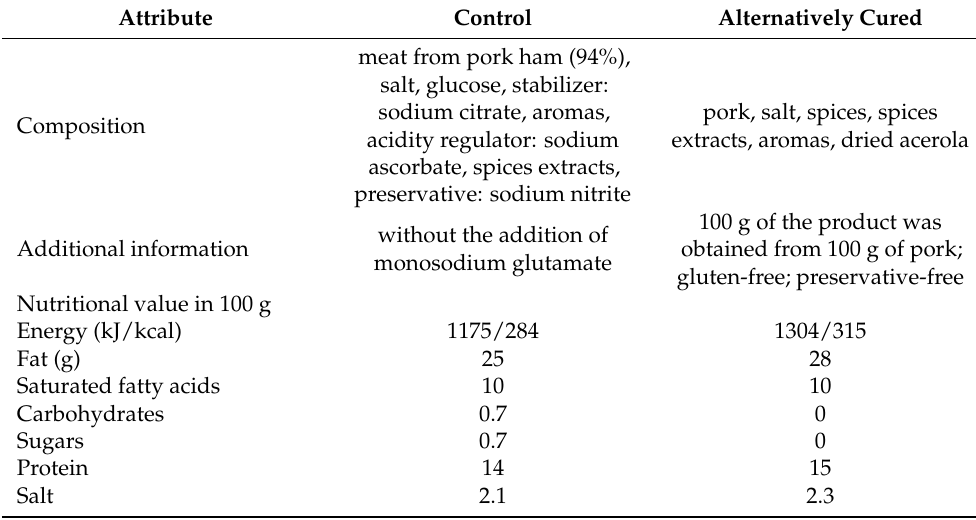
Table 1. Characteristics of sausages used in the